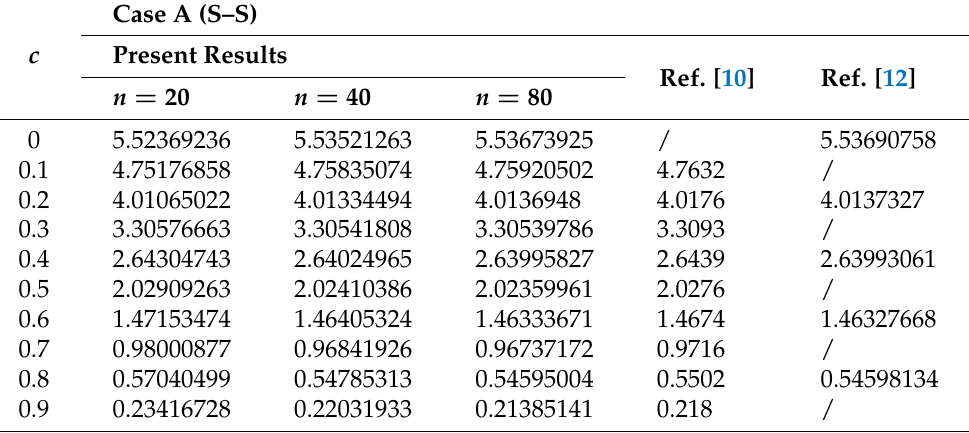
Table 2. Dimensionless critical load of an S–S axially FG Timoshenko beam with different taper coefficient ( m = 2).